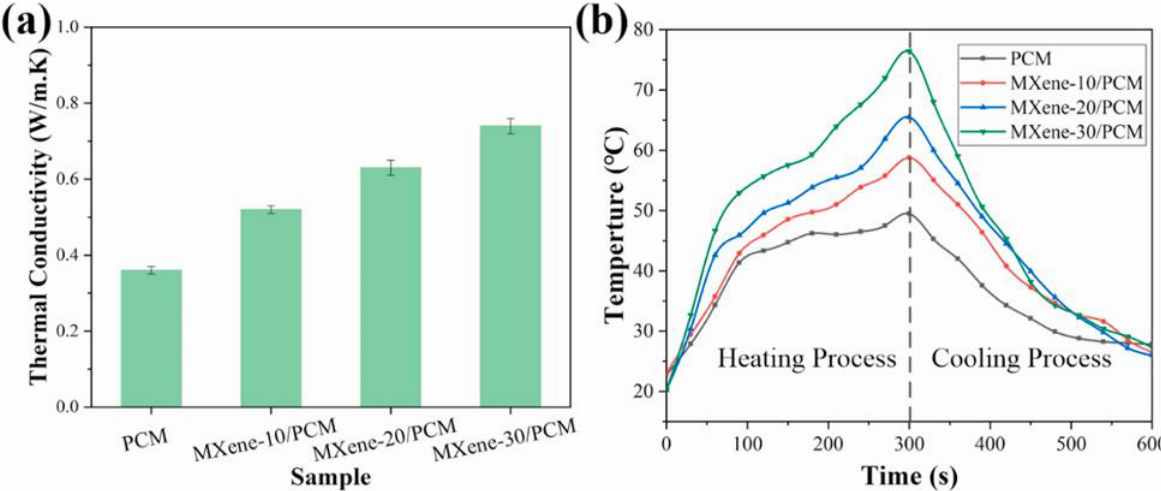
Figure 8. ( a ) Thermal conductivity of PCM and MXene/PCM; ( b ) temperature evolution curves of PCM and MXene/PCM during the heating and cooling process [95].